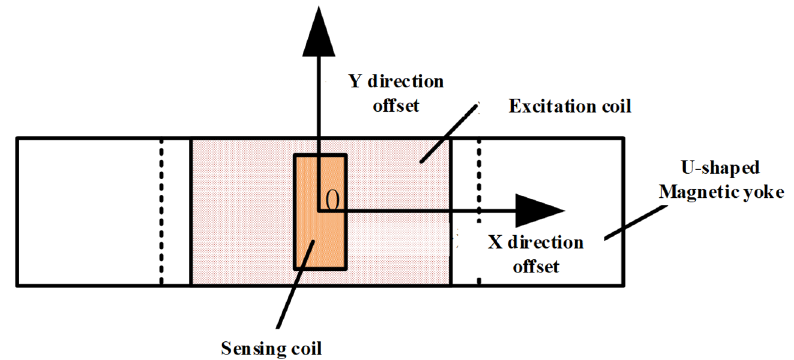
Figure 12. Schematic diagram of detecting the coil offset.